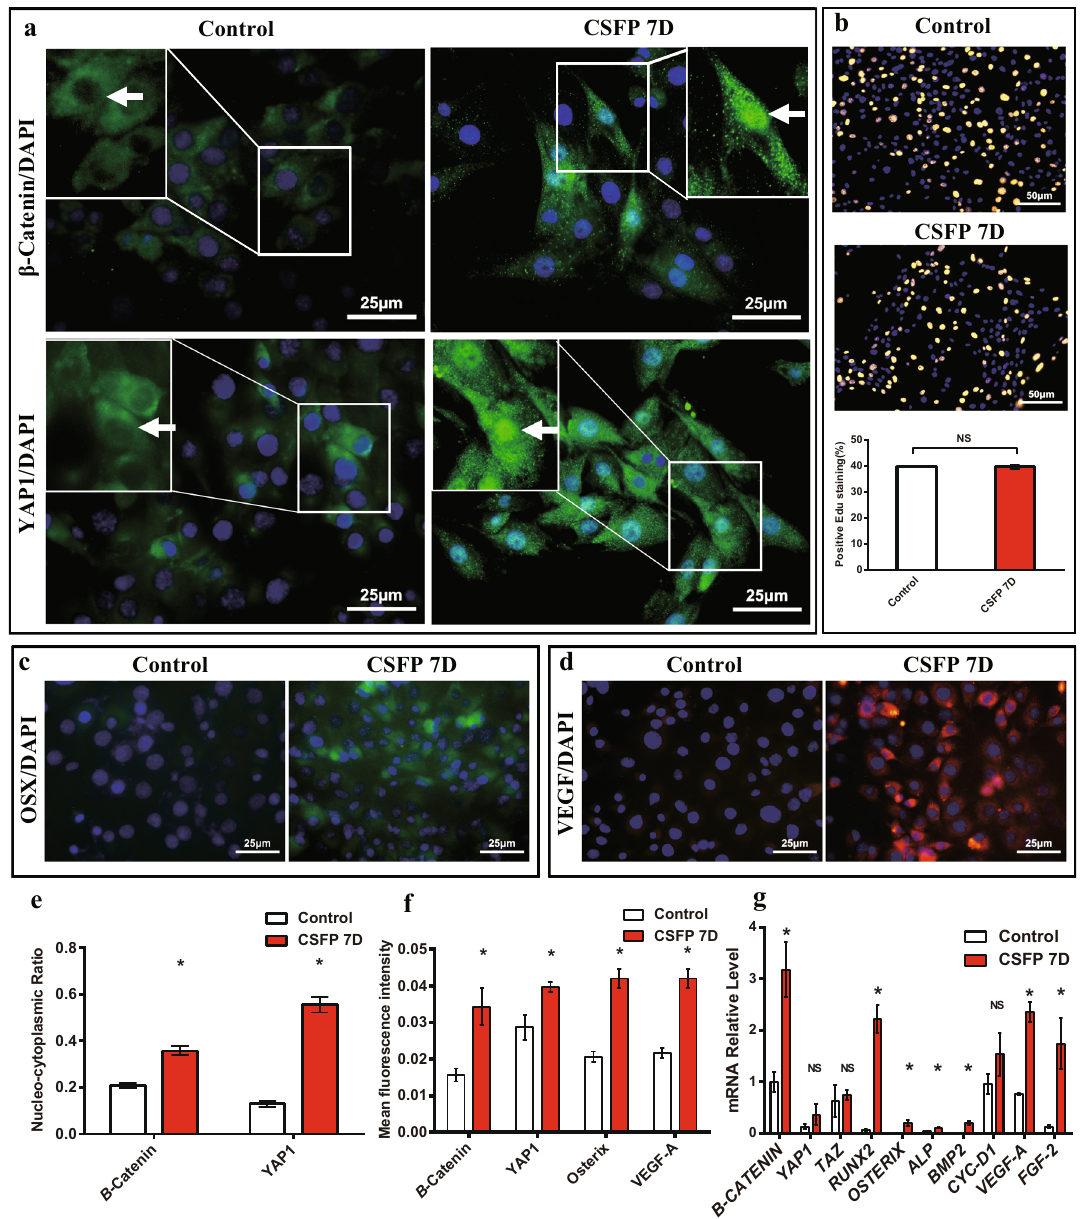
Fig. 2 CSFP promoted the expression and nuclear translocation of β -Catenin and YAP1, and promoted the osteogenic and angiogenic abilities of MSC. a IF staining of β -Catenin and YAP1, and the white arrow shows the nucleus. b Edu staining showed no statistical difference between two groups. IF staining of Osterix ( c ) and VEGF-A ( d ). e The nucleo-cytoplasmic ratio of β -Catenin and YAP1 in the CSFP 7D group was statistically higher than that of the Control group. f The mean fl uorescence intensity of β -Catenin, YAP1, Osterix, and VEGF-A in the CSFP 7D group was statistically higher than that of the Control group. g QRT-PCR analysis. Data are presented as mean ± SEM, and * P <